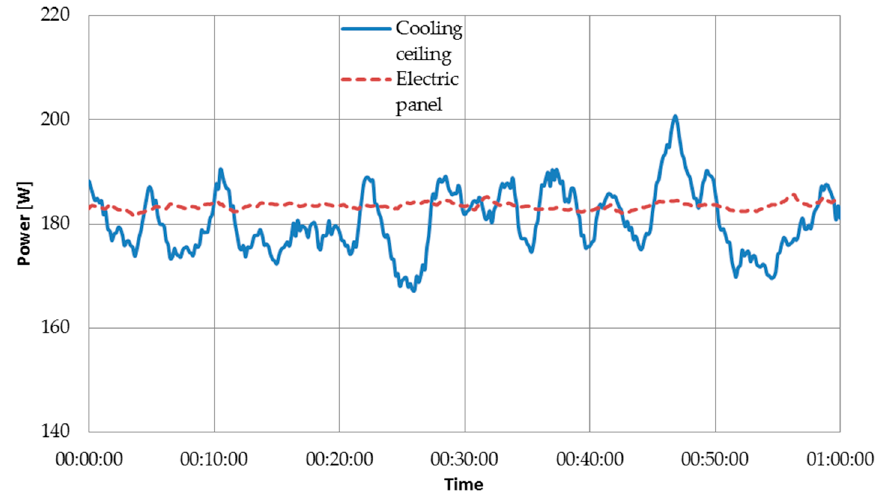
Figure 4. Experimental data of the steady state measurement. The heating power generated by the electrical panel (red dashed line) is balanced by the radiant ceiling (blue solid line).